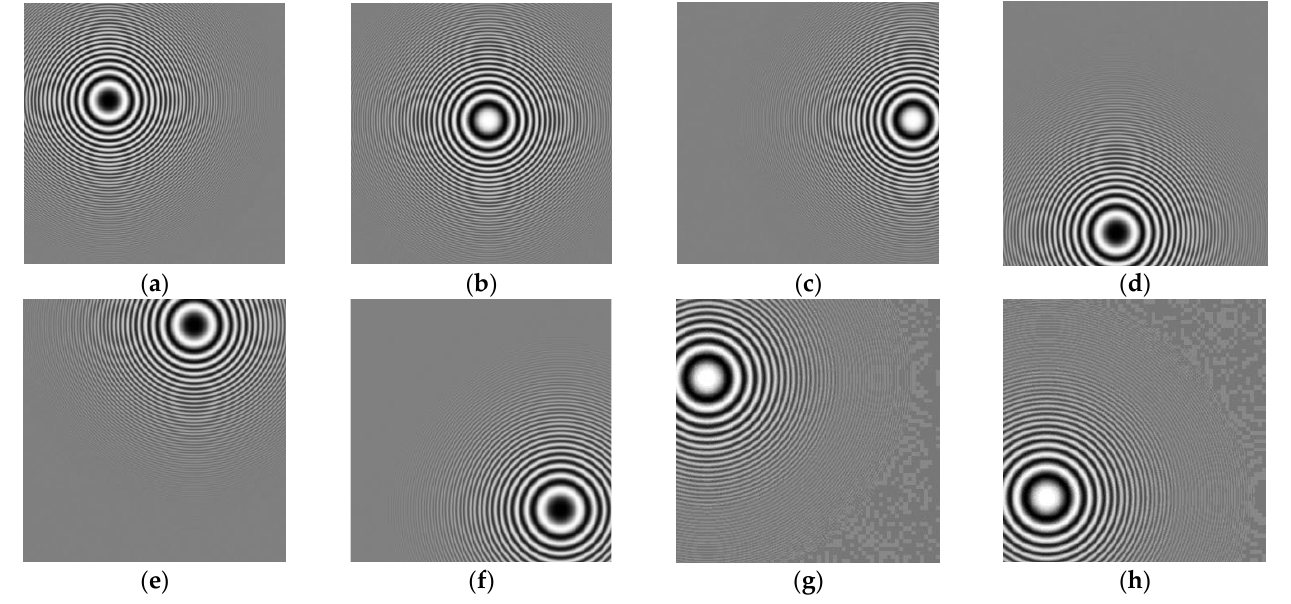
Figure 8. The eight separated circular fringe patterns ( a – h ) from the mixture signal shown in Figure 3b.